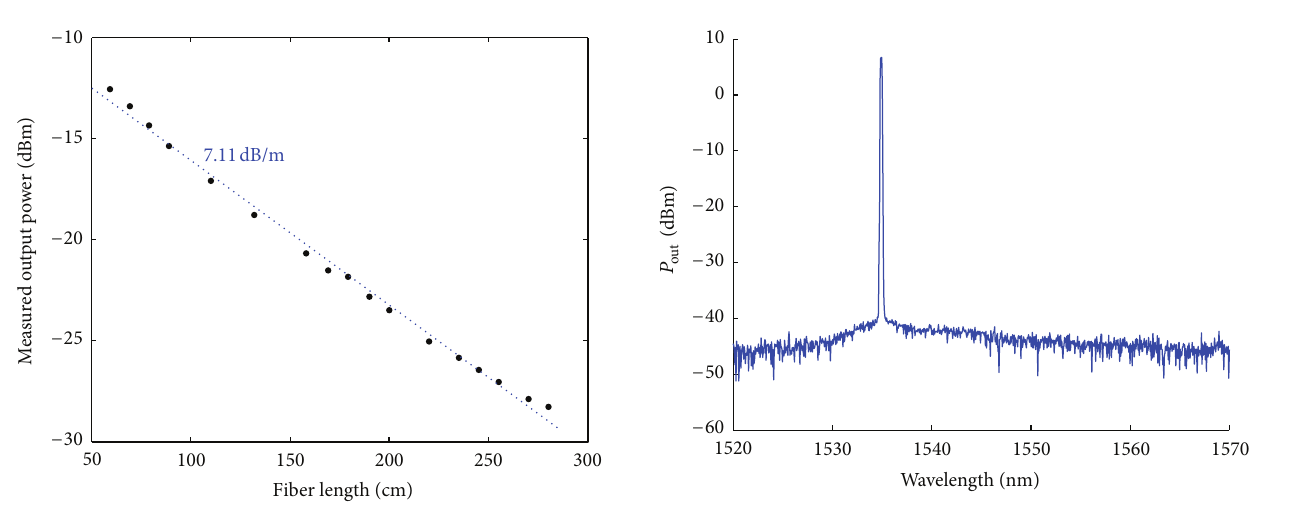
Figure 4: Amplifier output spectrum of the Yb 3+ /Er 3+ phosphate glass fiber obtained by exciting with a 479 mW pump at 975 nm and a 0dBm signal at 1535 nm. The highest peak obtained at these conditions is shown